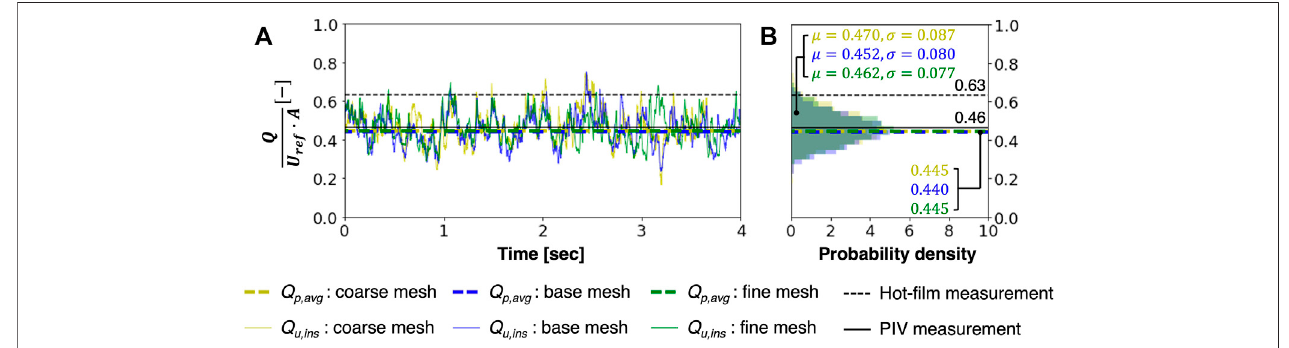
FIGURE 6 | Grid sensitivity study results for the dimensional ventilation rates: (A) Time series of ventilation rate calculated from the velocity fi eld, together with average ventilation rate estimated from the time-averaged pressure fi eld, and the experimental values; (B) Corresponding distributions and mean values.